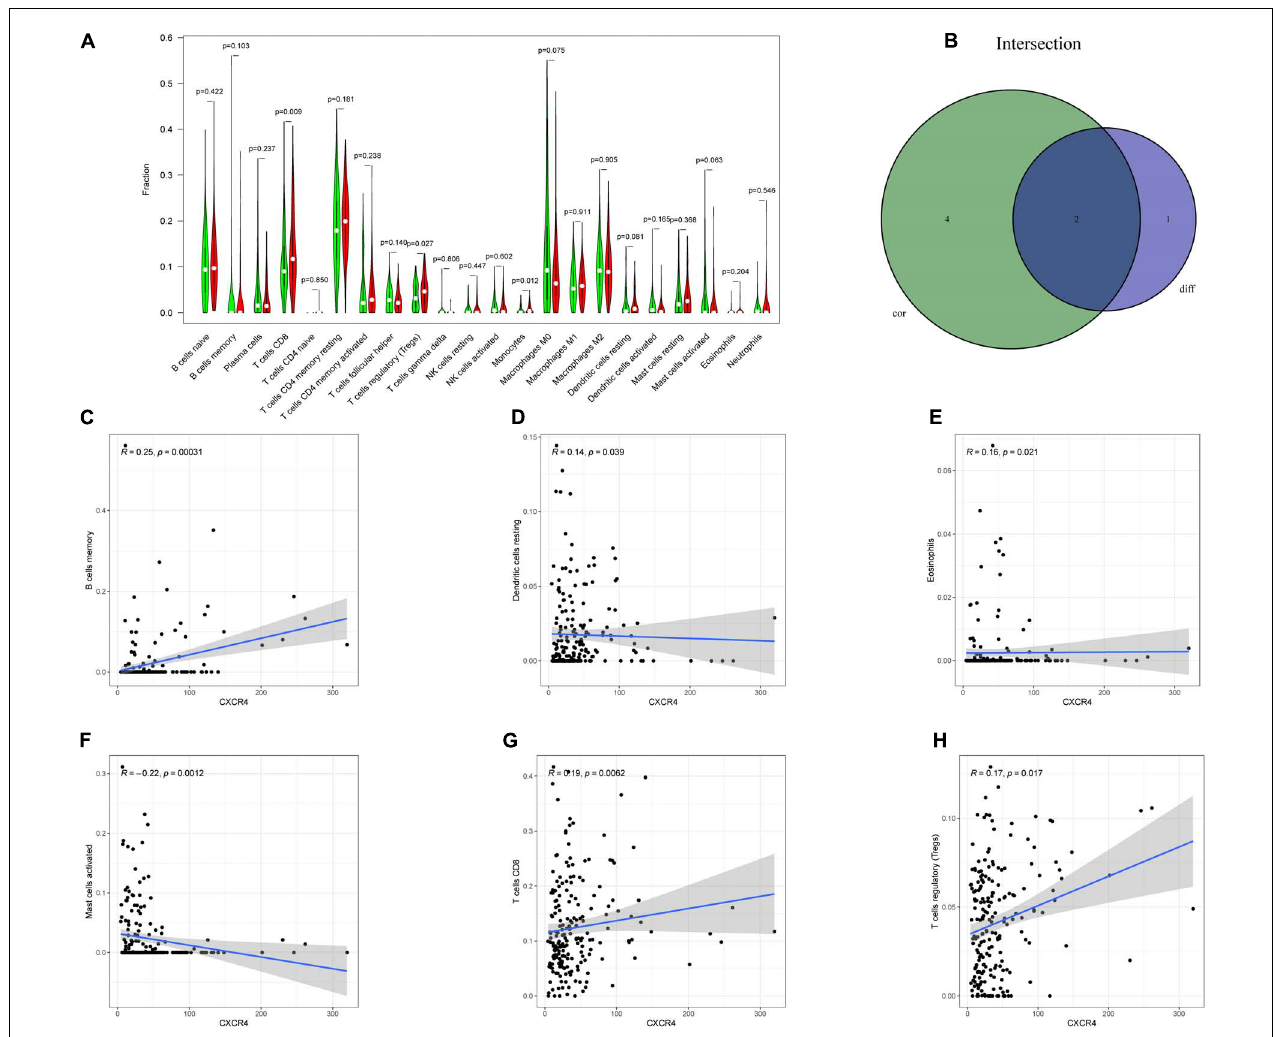
FIGURE 9 | Relation between the expression of CXCR4 and proportion of tumor-infiltrating immune cells (TIICs). (A) A violin plot showing the differences in the proportions of 21 different types of immune cells in GC tumor samples with low or high CXCR4 expression. (B) A Venn plot displaying the differences and correlation between two types of TIICs associated with CXCR4 expression. (C–H) A scatter plot showing the correlation of the proportions of TIICs with CXCR4